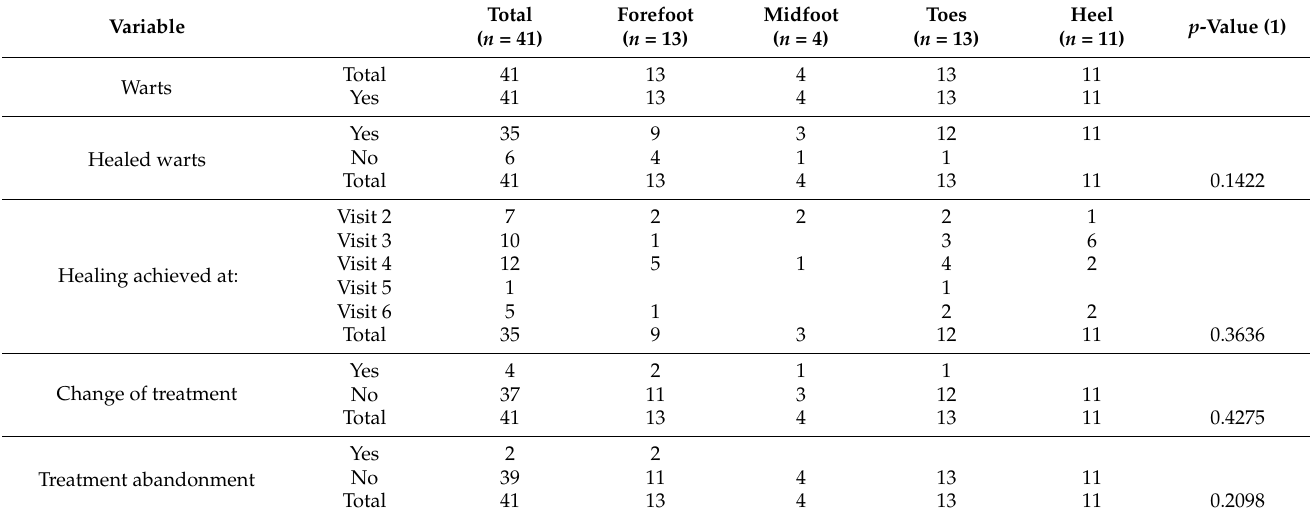
Table 2. Healed warts according to their location.